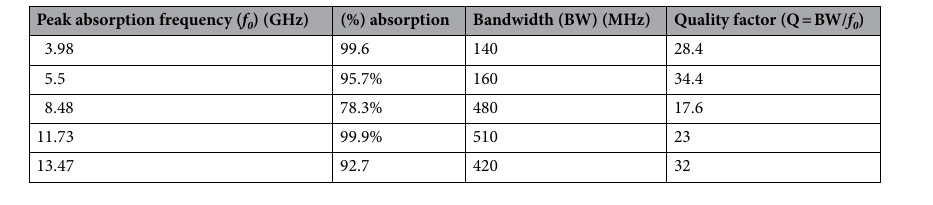
Table 3. Absorption property of the unit cell with full back plane.